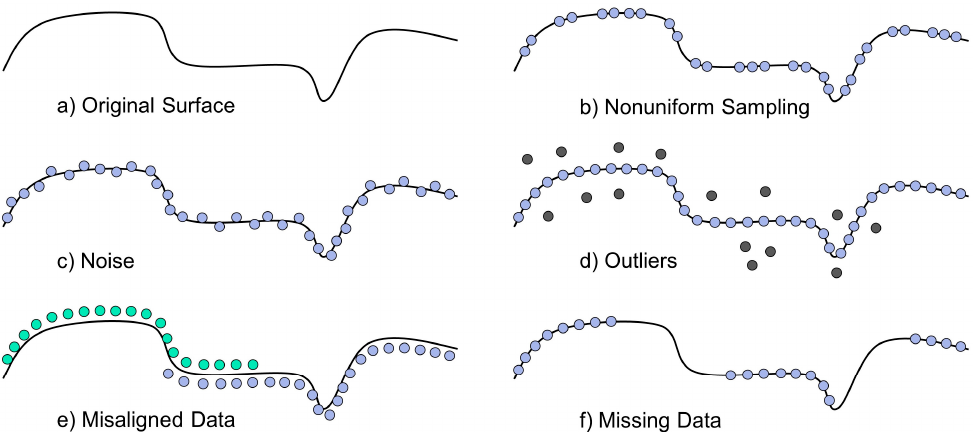
Figure 1. Point cloud imperfections known to challenge surface reconstruction algorithms: ( a ) The original surface being sampled; ( b ) Non-uniform sampling; ( c ) Noise; ( d ) Outliers; ( e ) Misaligned data; ( f ) Missing data. Adapted from Berger et al. [48].